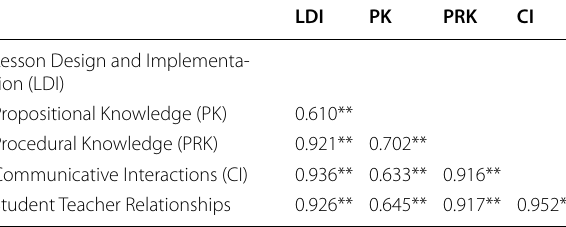
All correlations have n 484, all correlations statistically significant at p < 0.01** =